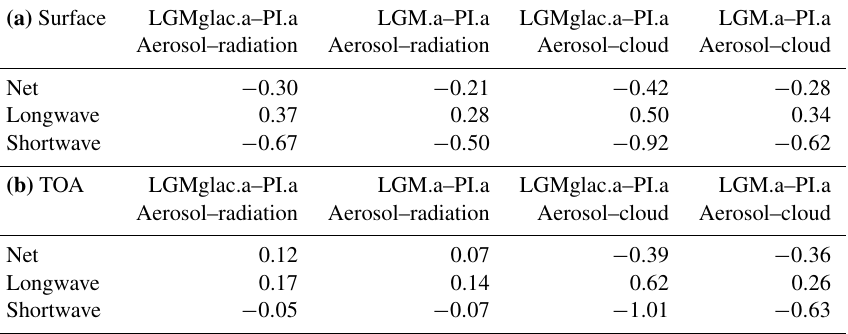
Table 3. LGMglac.a–PI.a and LGM.a–PI.a changes in global mean radiative perturbation by dust (a) at the surface and (b) at the top of the atmosphere (TOA) (Wm − 2 ).